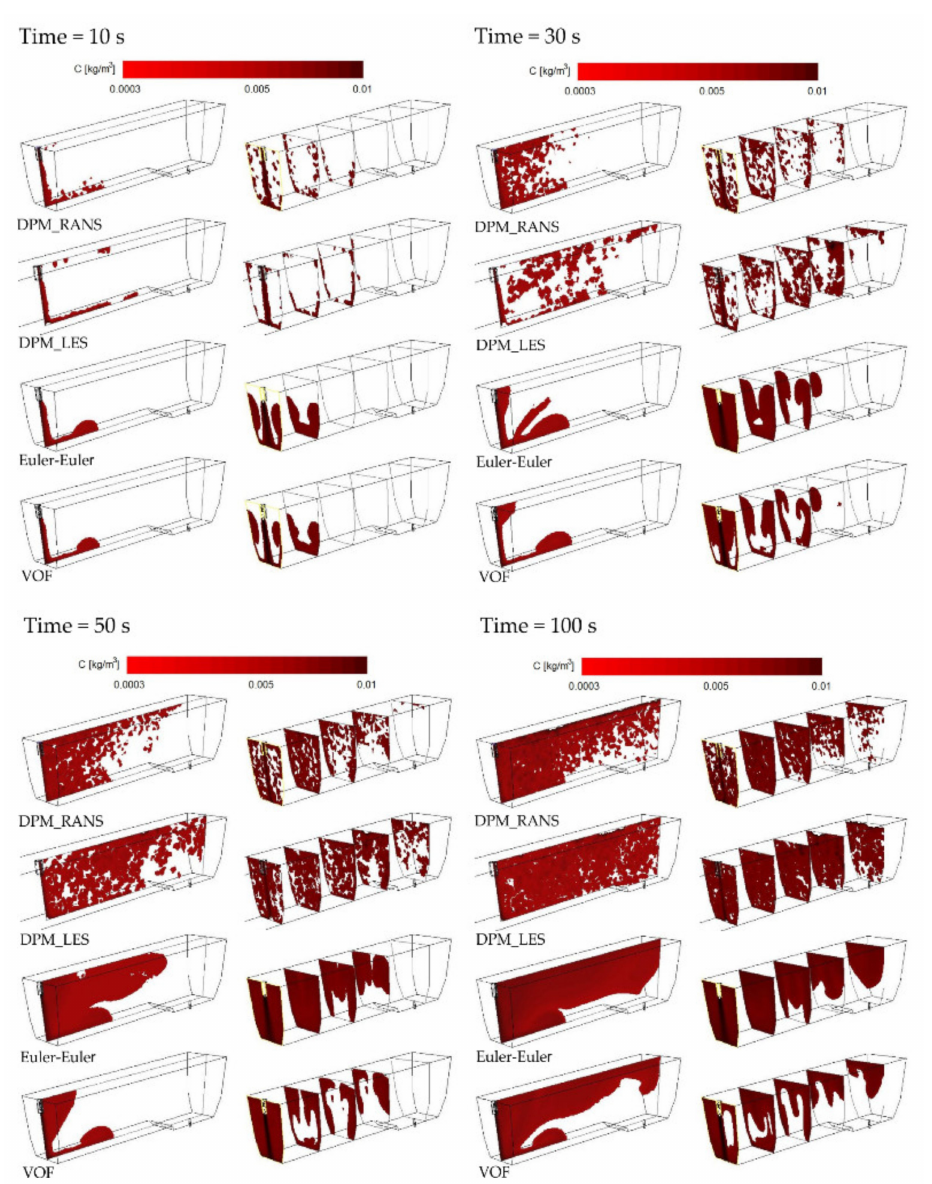
Figure 4. Contour maps of microparticles distribution (20 µ m) on the control